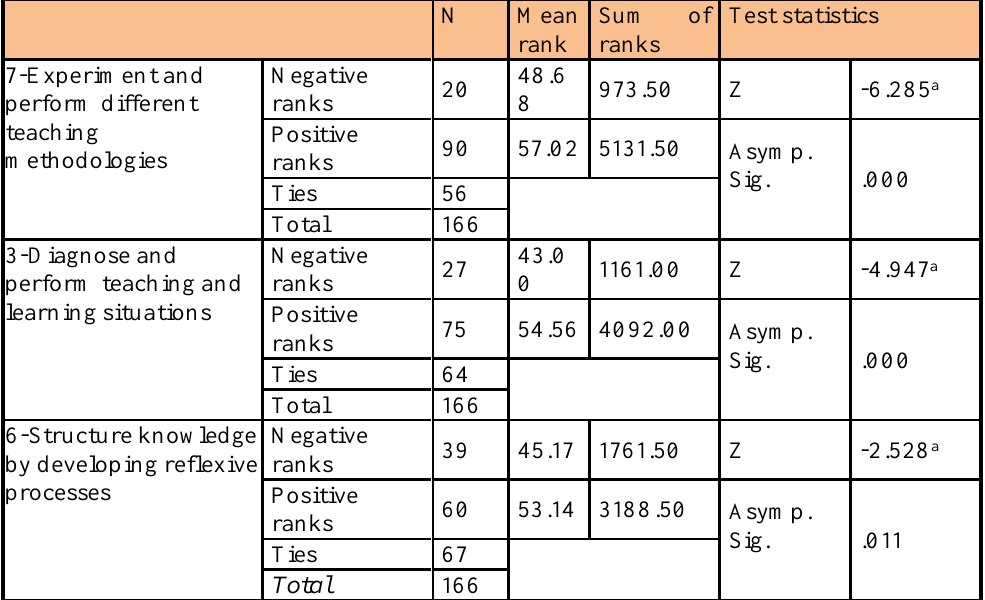
Table 8 Wilcoxon Signed Ranks Test. Median Difference on the Level of Proficiency and Professional Development Needs Regarding the Researcher Role Competencies Applied to Online